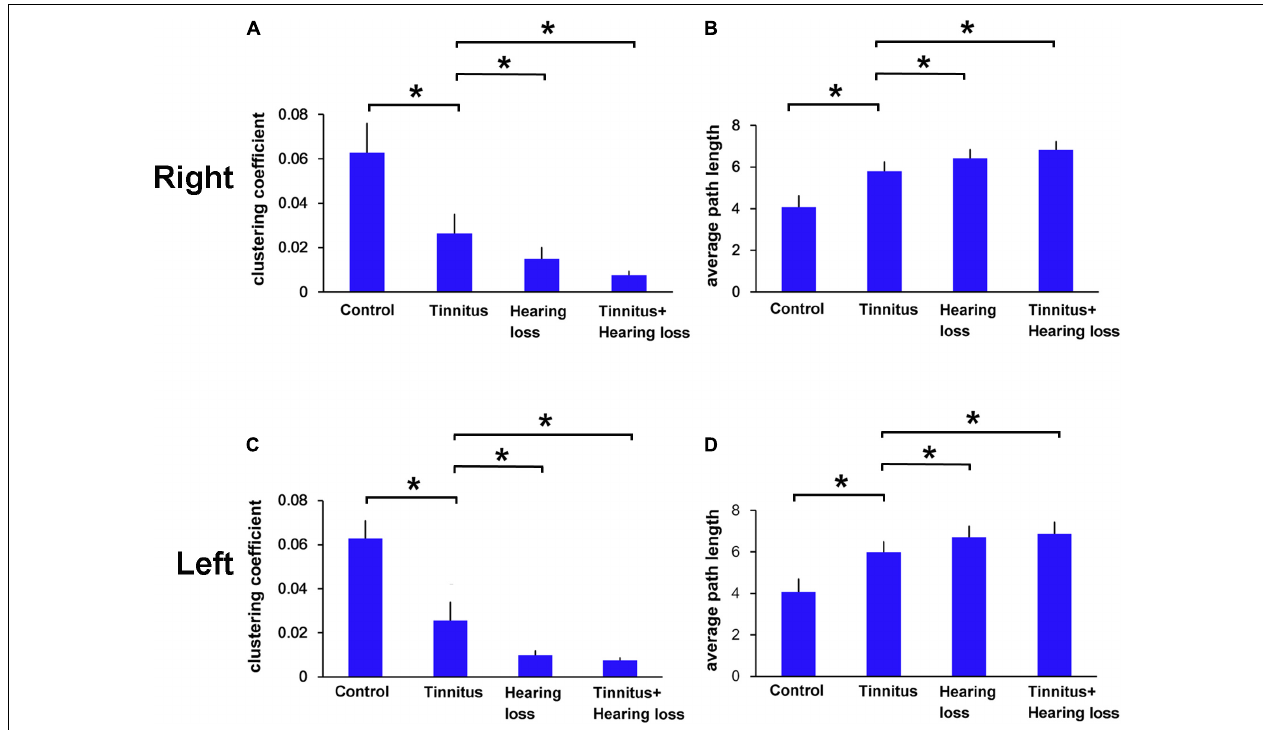
FIGURE 2 | (A–D) Comparison of the clustering coefficients and average path lengths for the right and left ears among the control, tinnitus and tinnitus/SNHL groups. * p <